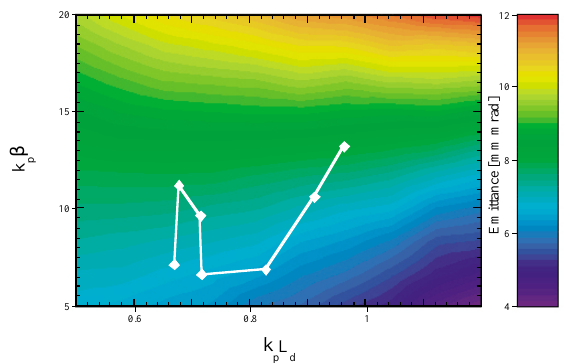
FIG. 9. (Color) Contour plot of the simulated quad scan emit- tance over a range of both k p L d and k p b . The white plot points locate the positions of the experimental data. The normal- ized emittance used as input to the simulations was 5 mm mrad, while the output emittance values range from 4 (deep blue) to 12 mm mrad